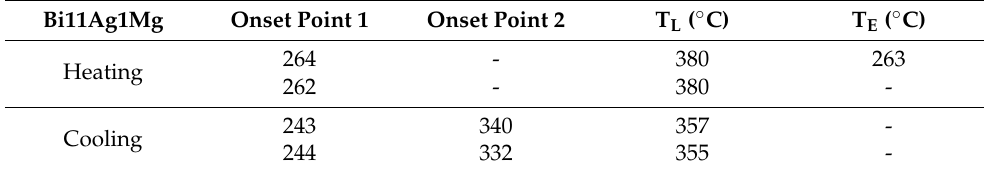
Table 3. Significant phase transformation temperatures were determined by TG/DTA